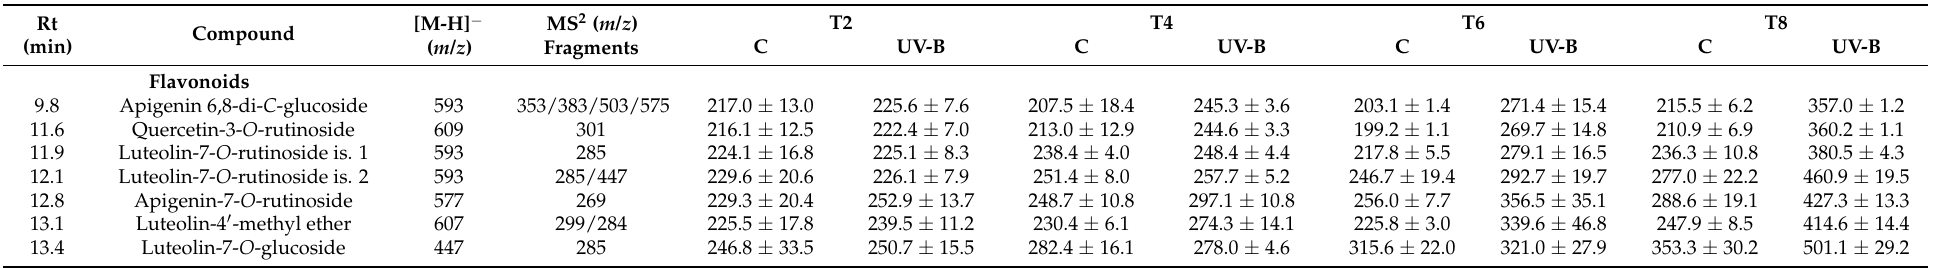
Table 2. Phenolic profile (mg kg − 1 DW) of Olea europaea leaves (Olivastra Seggianese variety) under control (C) and UV-B conditions sampled at the 2nd